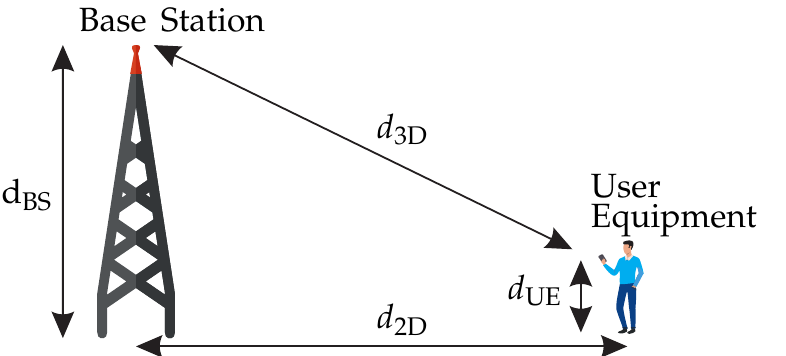
Figure 3. 3GPP model for Urban Micro (UMi) scenario, which includes the definition of height and distance.